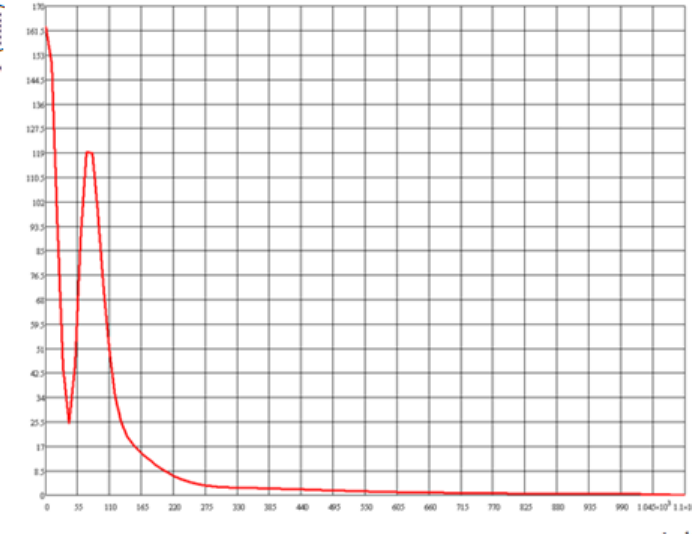
Figure 16. T-vc dependence for P20-conventional lathe.